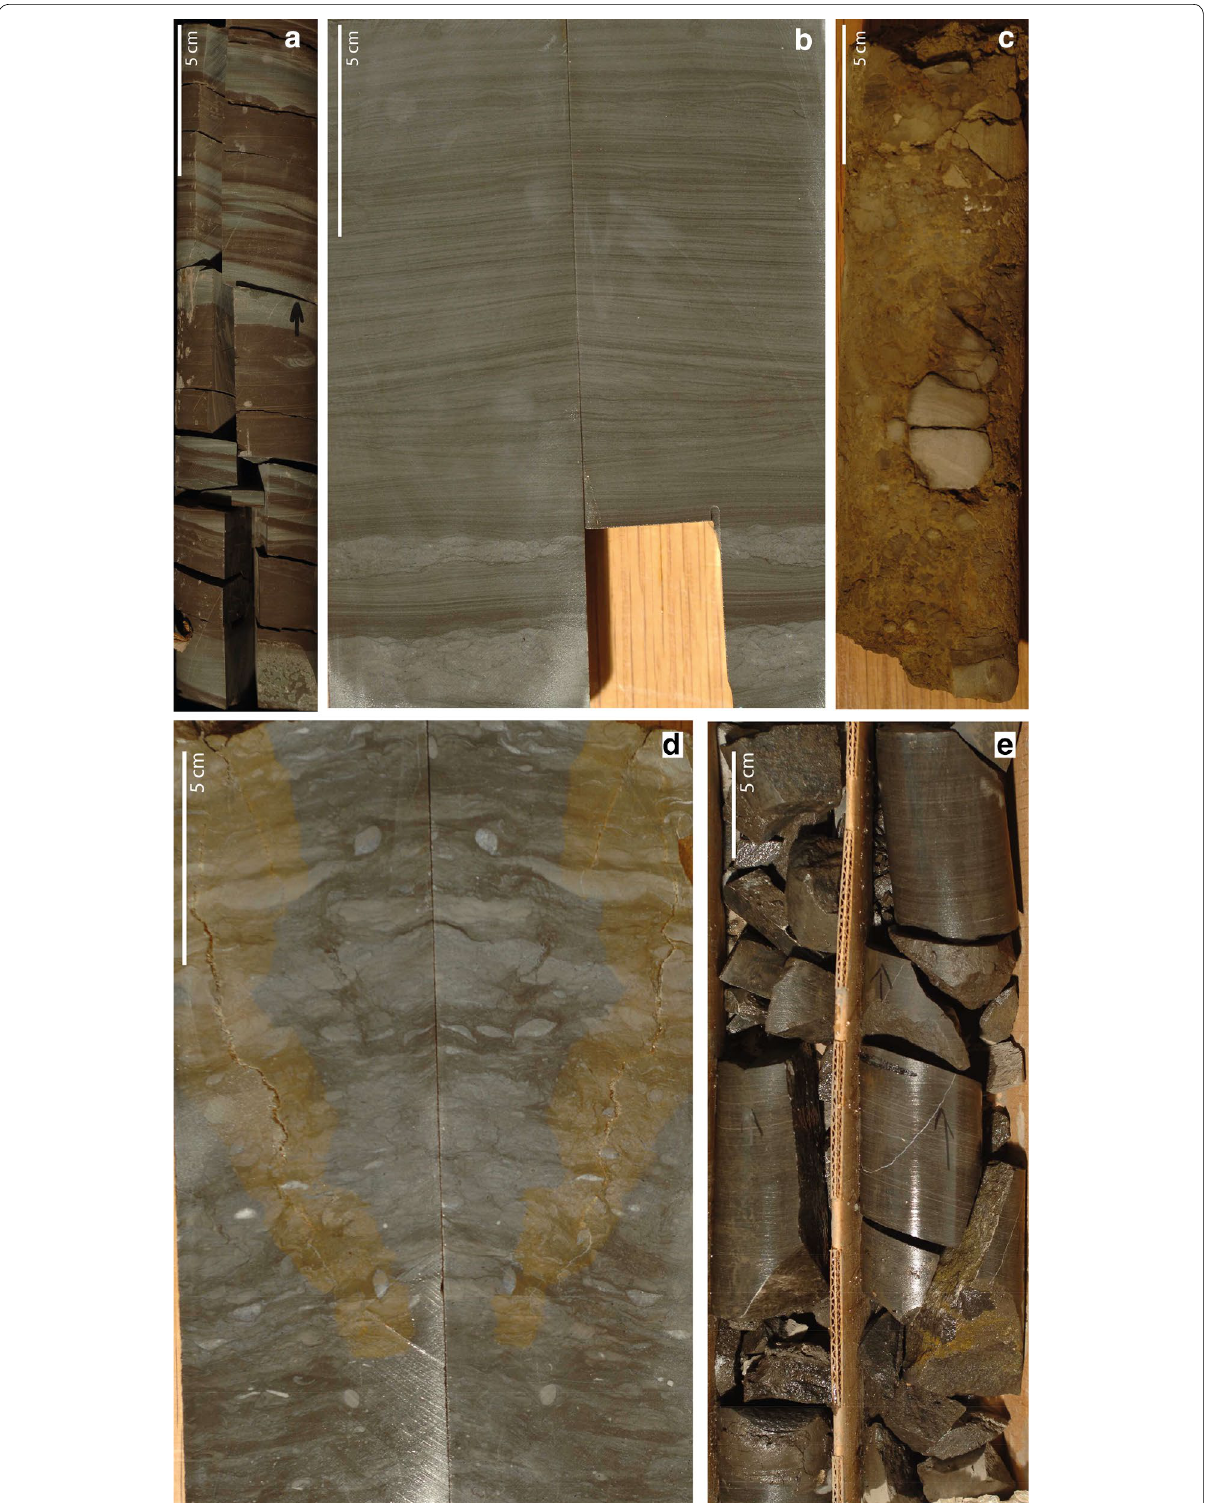
Fig. 2 Core pictures: a unit I, b unit II, c karstified interval unit V, d Meekoceras limestone facies unit III, e dark shaly limestone unit